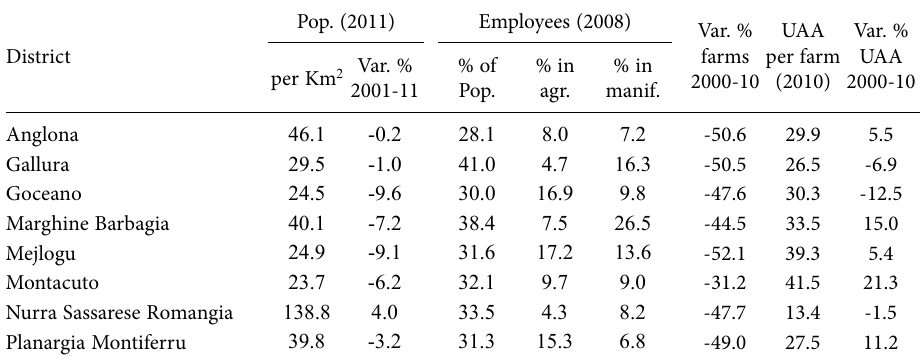
Pop. (2011) Employees (2008) Var. % Var. % farms per farm Pop.